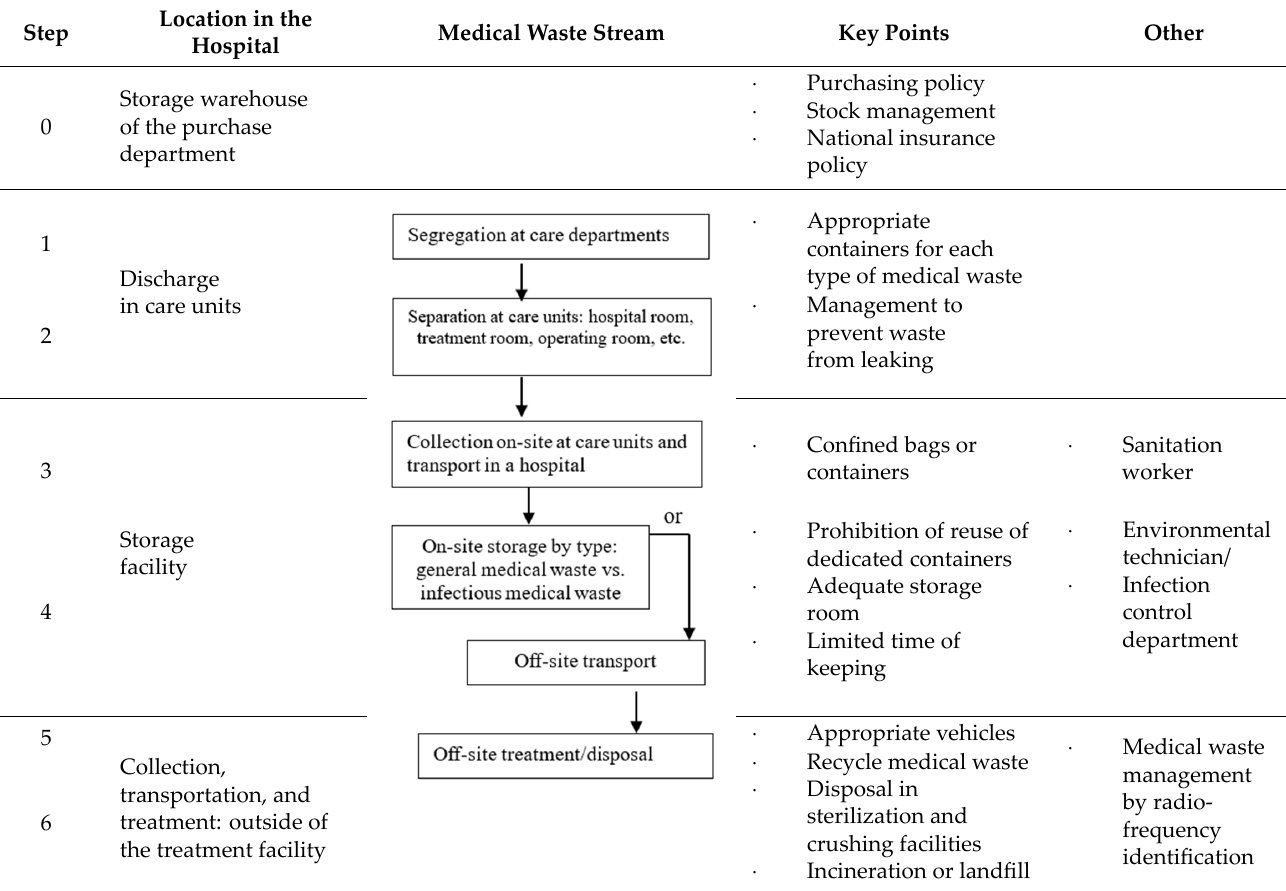
Table 2. Synopsis of the medical waste stream in Korean hospitals.